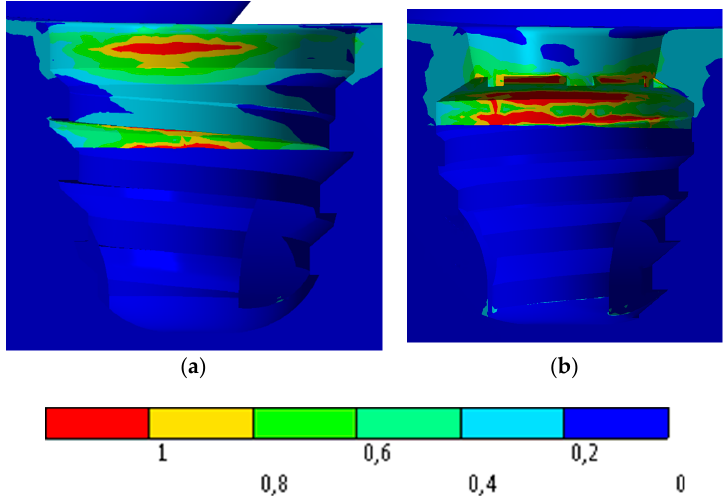
Figure 11. Stress distribution on bone with an oblique load: ( a ) IH connection; ( b ) MT connection.